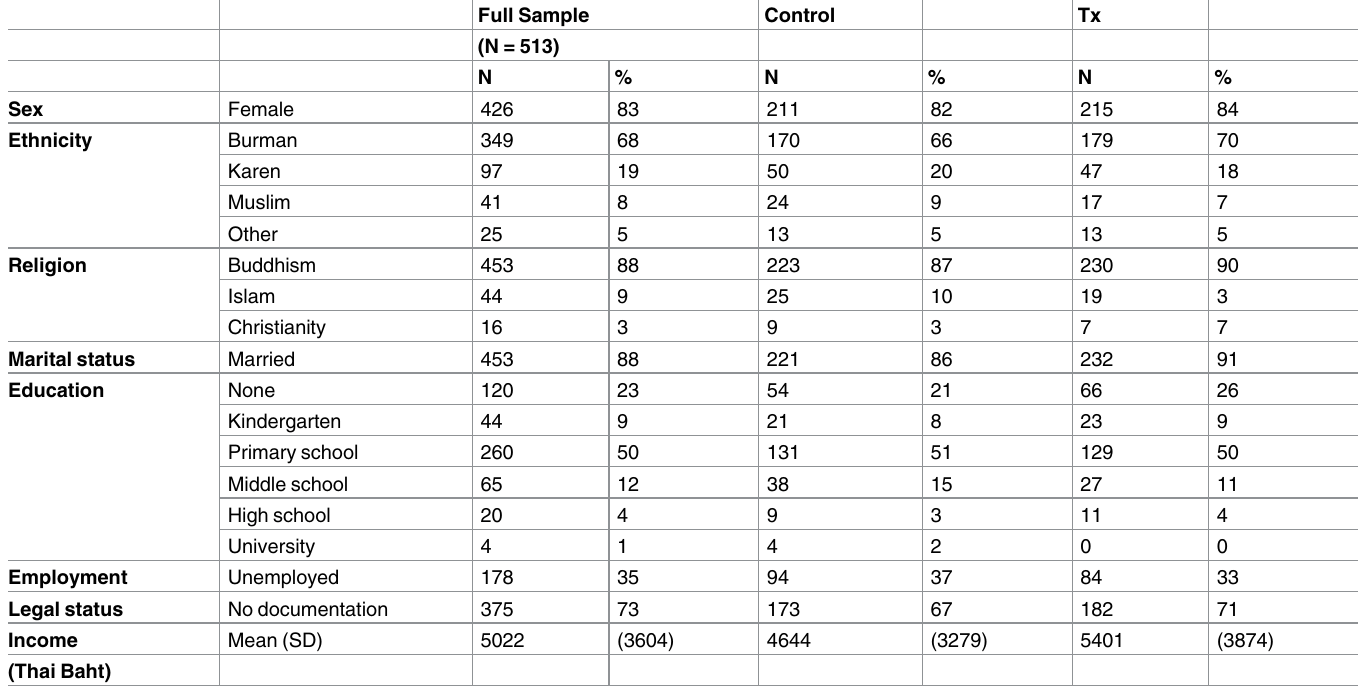
Table 2. Caregiverdemographics.